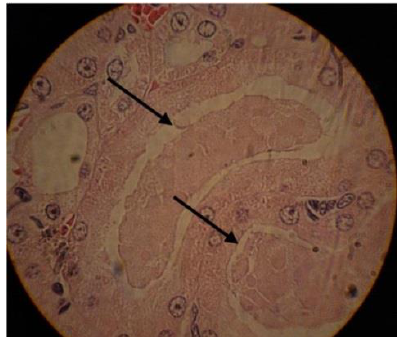
Figure 7. The hematoxylin and eosin (H&E) staining results of kidney tissue in cisplatin receiver mice. The arrows show the acute tubular necrosis (ATN) injury (×40).